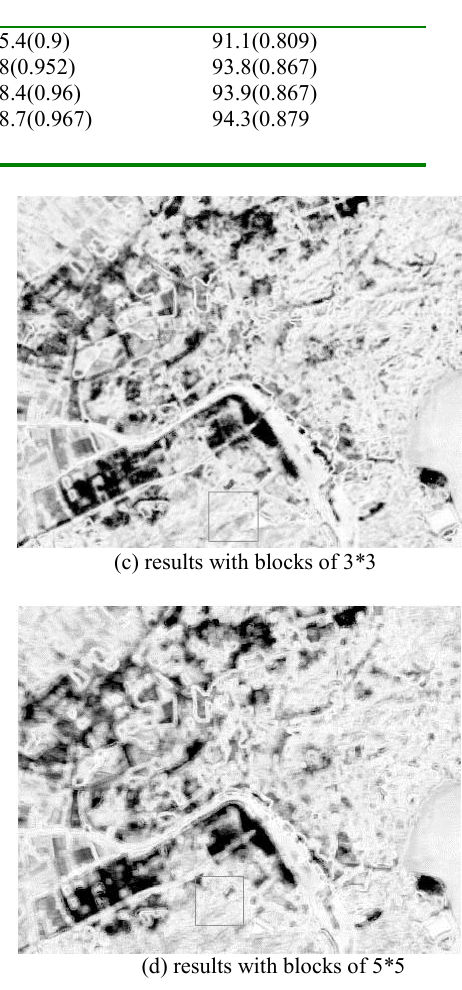
Figure 9 Another bi- temporal images and